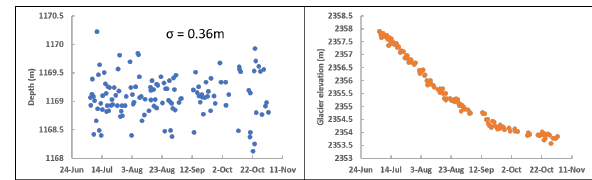
Figure 8. Left: depth of a pixel over fixed areas on images of Argentiere glacier during summer 2019. Right: elevation computed from depth of a pixel over the glacier.